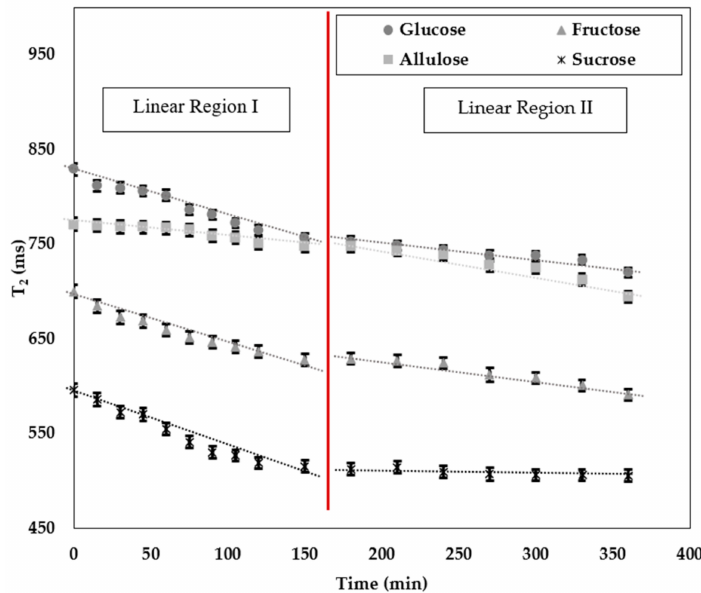
Figure 2. T 2 (ms) relaxation times of sugars obtained at different times. Data for T 2 times are expressed as mean ± SE ( n =